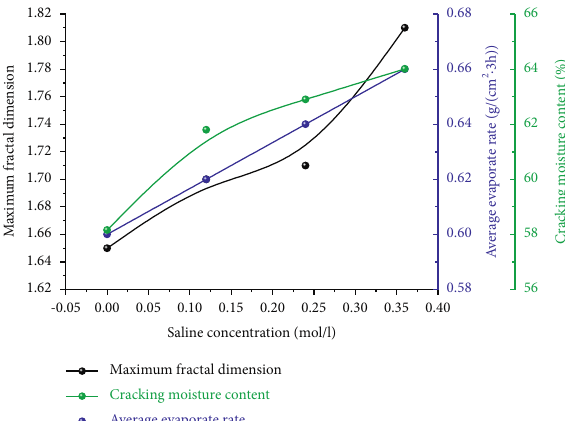
Figure 7: Maximum fractal dimension, average evaporation rate, and cracking moisture content varying with saline concentration.